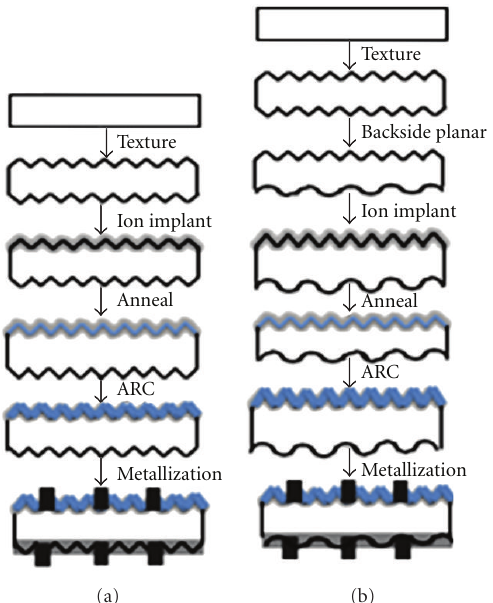
Figure 1: Comparison of ion implantation process with and without backside rounding process flow. (a) Ion implantation process without backside rounding process. (b) Ion implantation process with backside rounding process.